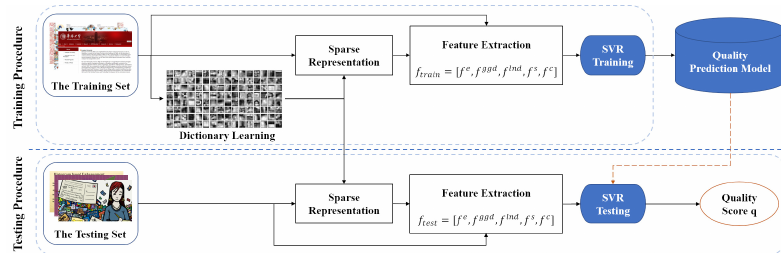
Figure 3. The flowchart of image processing at each